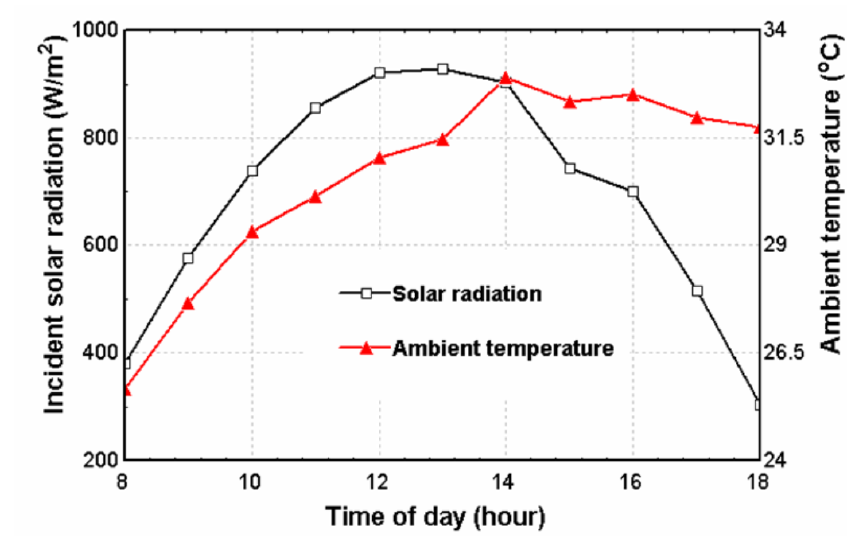
Figure 7. Meteorological data of solar farm used in this study.